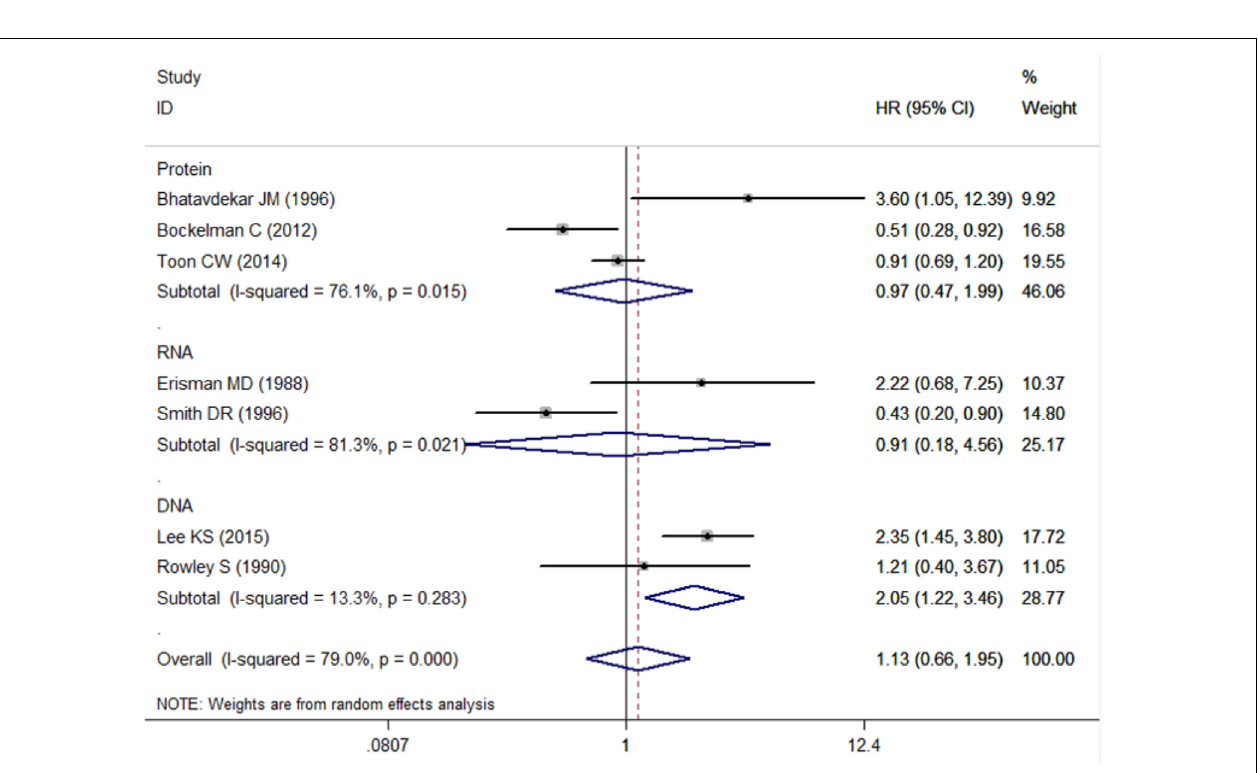
Frontiers in Physiology |